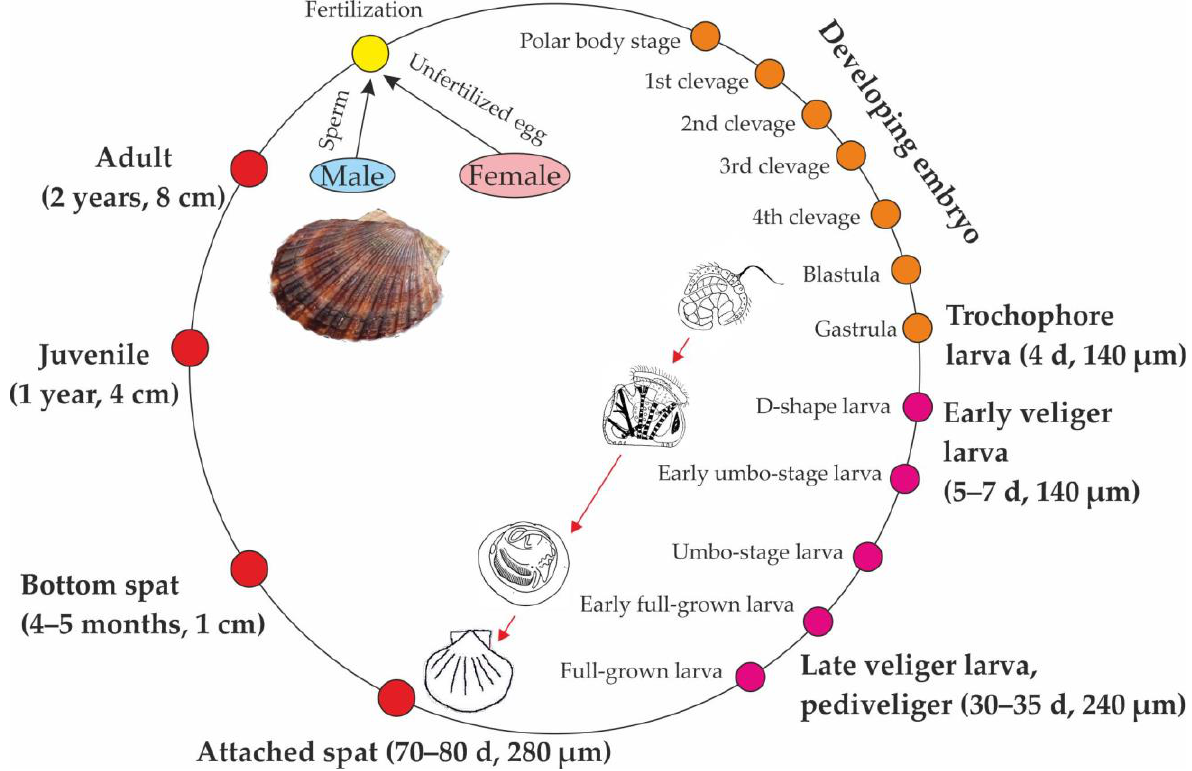
The life cycle (Figure 1) starts when demersal eggs of Mizuhopecten yessoensis (average diameter 60–70 µ m) are fertilized in the sea. age diameter 60 – 70 µm) are fertilized in the sea.